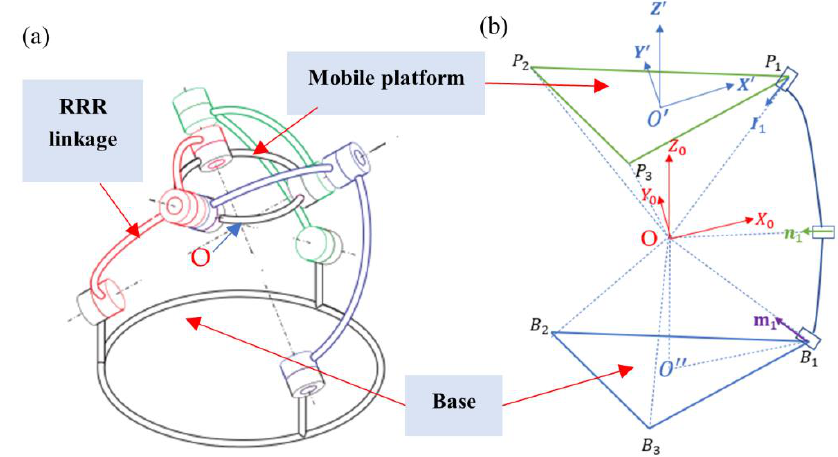
Figure 1. ( a ) The schematic of the SPR (Reprinted with permission from [27]. Copyright 2007 IEEE.). ( b ) The initial state of the SPR.